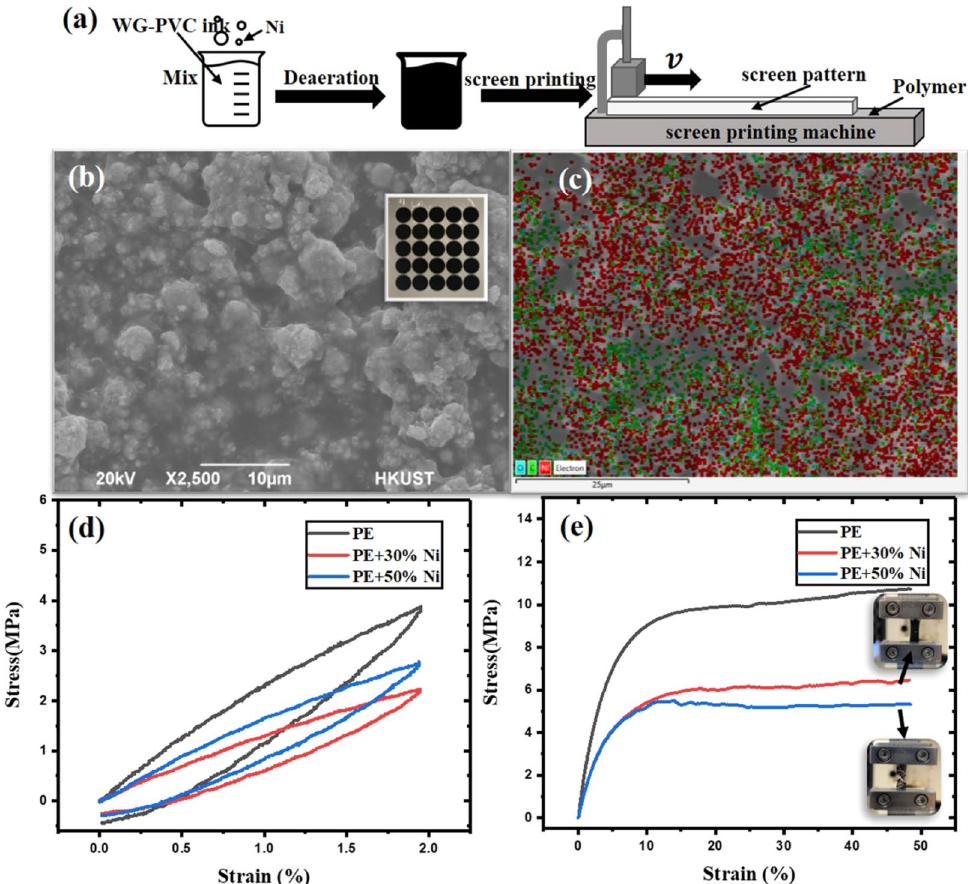
Figure 1. ( a ) Manufacturing process of the magnetic nanoparticle-enhanced diaphragm. ( b ) SEM image of the magnetic nanoparticle-enhanced diaphragm; the inset is the manufactured magnetic nanoparticle-enhanced membrane. ( c ) Elemental analysis of the surface of the magnetic nanoparticle-enhanced membrane; Ni is evenly distributed in the ink, and the red color represents Ni nanoparticles, while the green color represents the carbon element, which is the component of the ink. ( d ) Loop tensile test of different membranes: strain-stress curves. ( e ) Ultimate tensile test of different membranes: strain-stress curves. The insets show the deformation of 30% Ni printing PE and 50% Ni printing PE after 50% strain. It can be seen that the printing of 30% Ni is still well bonded to the PE membrane, but the 50% Ni printing has cracked on the PE